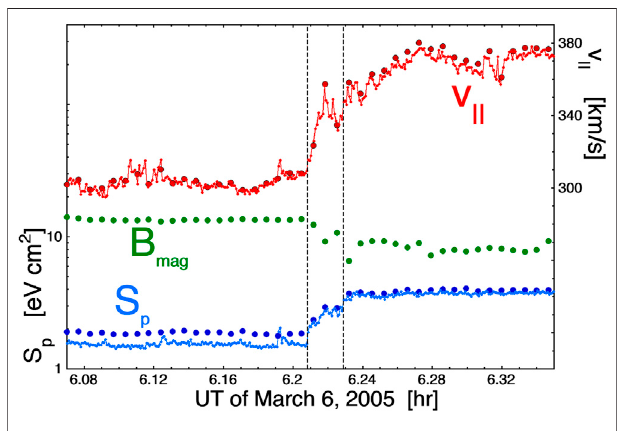
FIGURE2| AstreaminterfaceonMarch6,2005at1AUismarkedwithtwo vertical dashed lines. Using 3-s resolution (small points) and 15-s resolution (large points) measurements from the WIND spacecraft, the proton speci fi c entropy S p and themagnetic- fi eld strength B mag [nT] arelogarithmicallyplotted with the left axis and the component of the solar-wind fl ow velocity v || parallel to the local Parker-spiral direction is plotted linearly on the right axis. The separation between the vertical dashed lines is ∼ 20000 km perpendicular to Parker-spiral orientation.